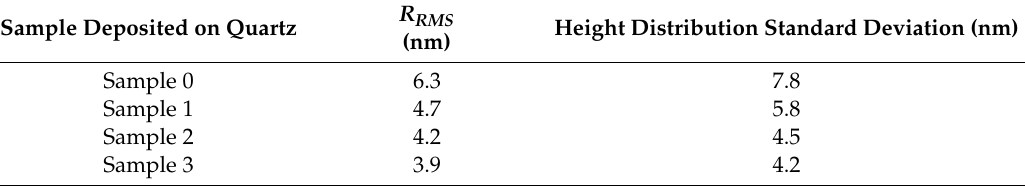
Table 3. R RMS of Cu 2 O thin films and height distribution standard deviation, derived from histograms of 2D AFM